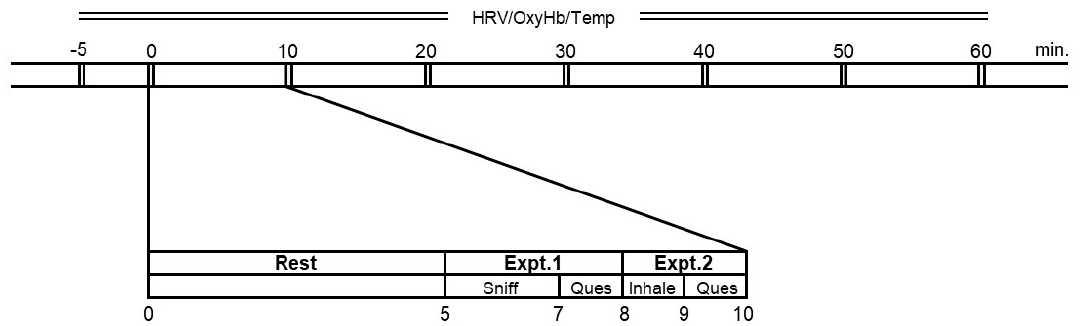
Figure 4. Experimental procedure. Heart rate variability, oxygenated hemoglobin and core body temperature were continually measured before, during and after the experiment. Questionnaires for subjective assessments, the irritation scale, the hedonic scale and the VAS were administered immediately after sniffing or inhaling the aroma of the experimental materials. Abbreviations are as follows: HRV, heart rate variability; OxyHb, oxygenated hemoglobin; Temp, core body temperature; Sniff, sniffing; Inhale, inhaling; Ques, questionnaires; Expt.1, experiment 1; Expt.2, experiment 2.